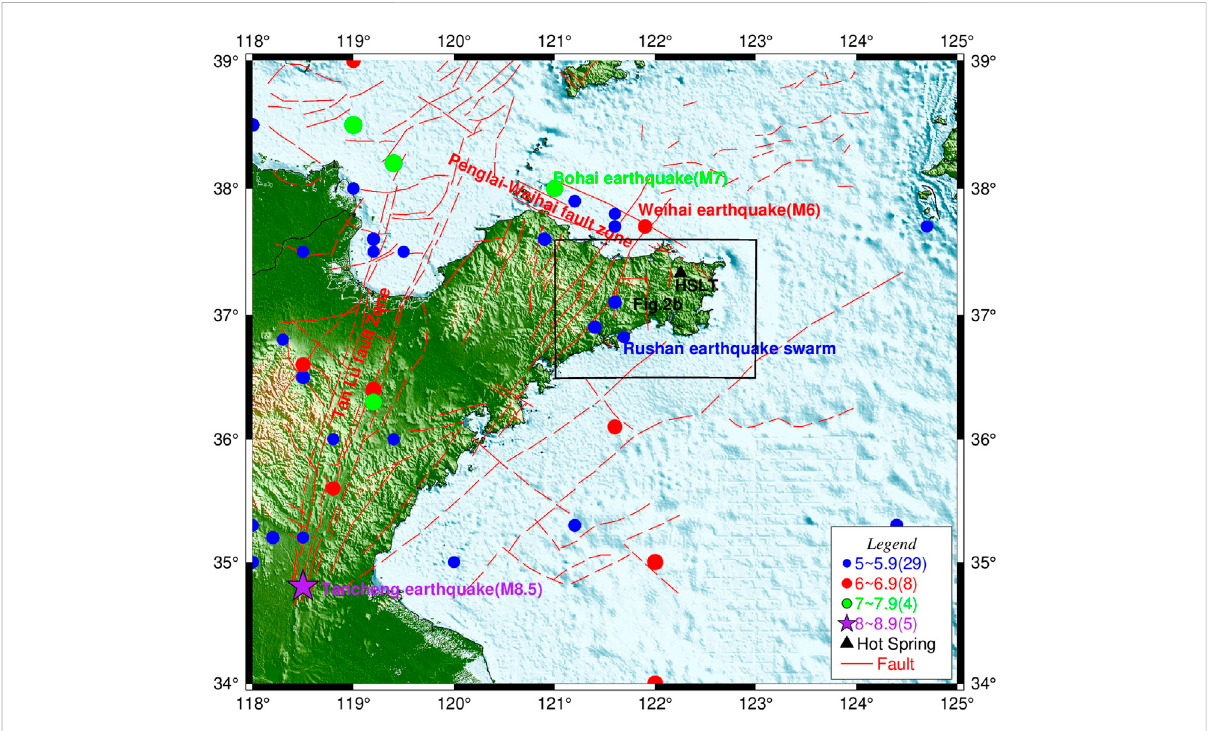
FIGURE 1 Seismotectonic settings of the Hongshuilantang Hot Spring in Jiaodong Peninsula, China. (Data of faults and earthquakes are from Chao et al.,